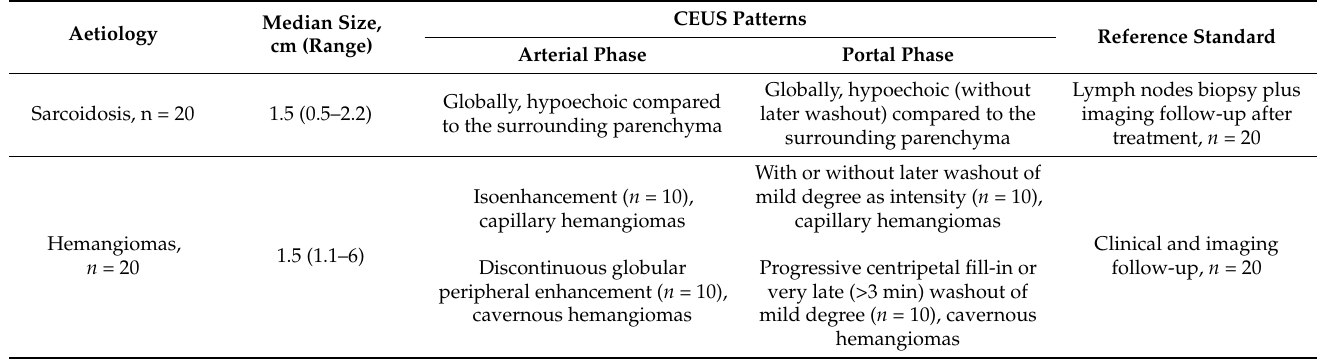
Table 2. Contrast-enhanced ultrasonography (CEUS) dynamic patterns of the benign